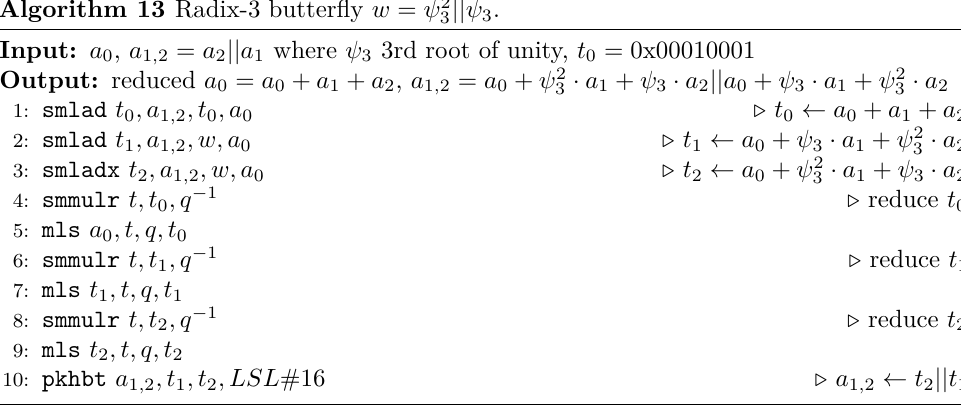
Algorithm 13 Radix-3 butterfly w = ψ 2